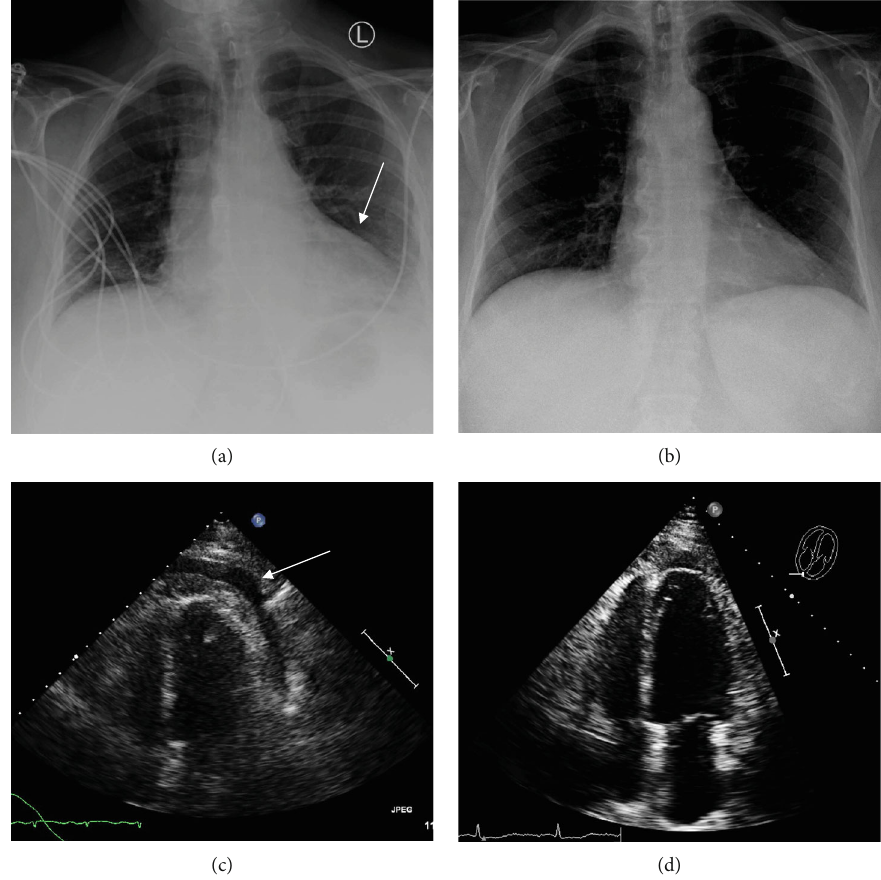
Figure 2: CXR/TTE before (left) and after (right) pericardial lipoma resection. (a) Findings: enlarged cardiac silhouette with epicardial fat pad sign. Impression: cardiomegaly with mild left basilar atelectasis. (b) Findings: the cardiomediastinal silhouette appears WNL. No evidence of pulmonary vascular congestion. Impression: no acute process. (c) Findings: moderately sized pericardial e ff usion presents circumferentially around the entire heart. (d) Findings: no evidence of cardiac tamponade and minimal remnant pericardial e ff usion. Table 1: Preliminary laboratory